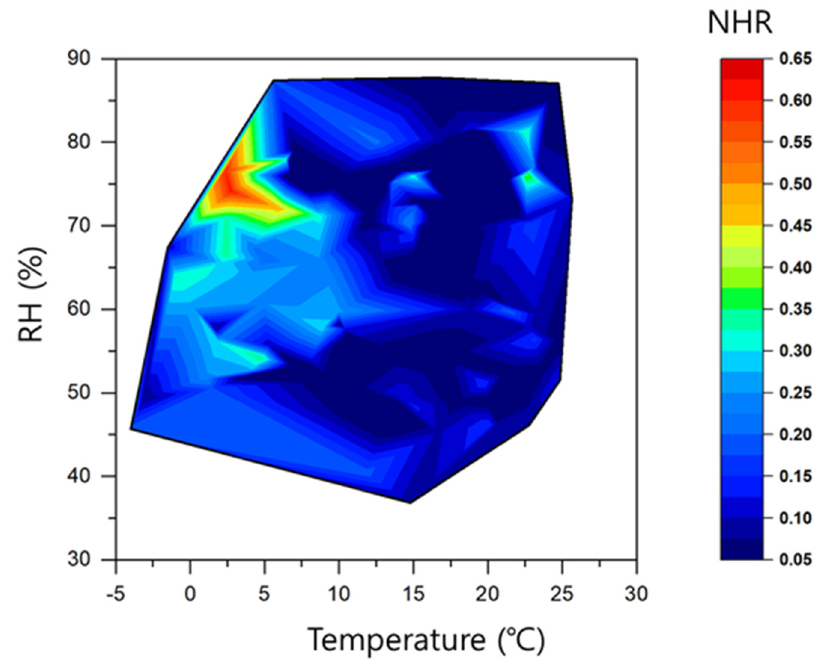
Figure 7. Daily average conversion ratios of NH 3 to NH 4+ (NHR) as a function of temperature and relative humidity (RH) during the entire measurement period.